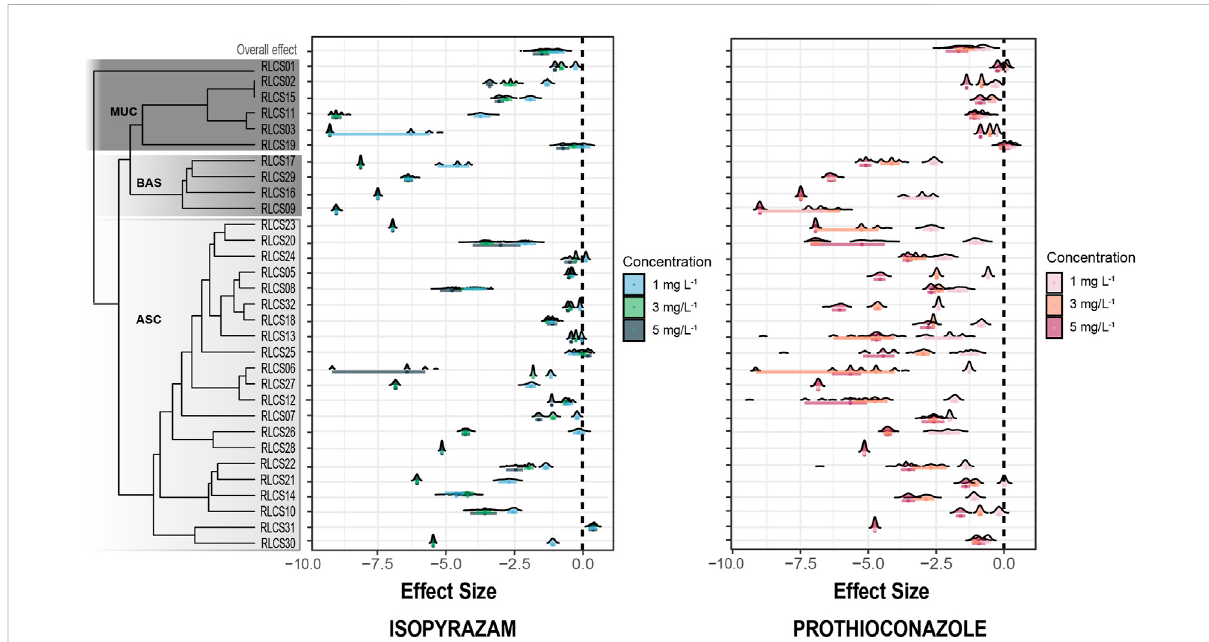
FIGURE 3 Effect sizes of fungicide treatment on the colony extension rate (CER) of individual isolates. Effect sizes (ES) are calculated as the natural logarithm of the response ratios of the treatment and control mean values (LRR = ln ( (cid:1) X t / (cid:1) X c ). Dots represent the effect sizes for individual isolate. Kernel density plots display the data distributions including the 95% con fi dence intervals as represented by the bars. Phylogenetic af fi liations of the isolates are indicated on the left, with the three phyla (MUC, Mucoromcota; BAS, Basidiomycota; ASC, Ascomycota) indicated by shading. The overall effect of each fungicide is also included on the top row of each panel. Dashed line represents zero effect size.